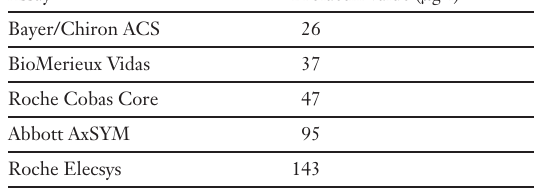
Prolactin values de- termined by differ- ent assays in the same serum sam- ple, containing 93% macroprolactin (and an actual value for monomeric pro- lactin of 7.1 µ g/l) (Fahie-Wilson, personal communi-